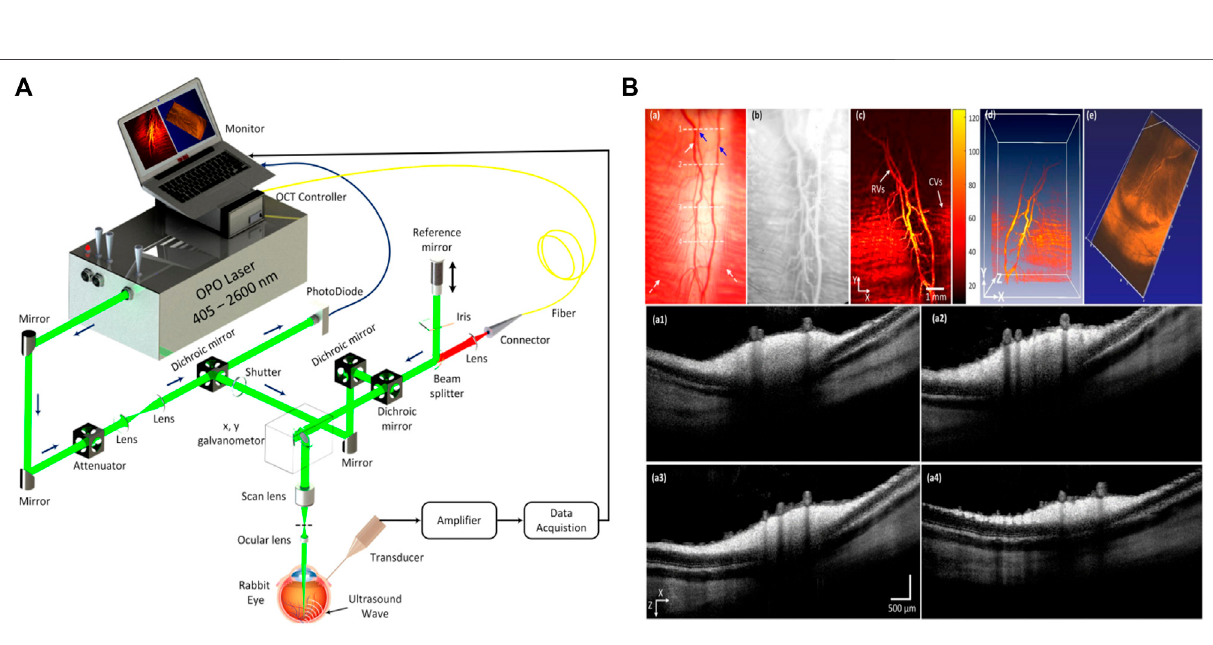
FIGURE 8 | (A) Schematic diagram of the integrated PAM and OCT systems for multimodal retinal imaging. Reprinted with permission from [147]; (B) images of retinal blood vessels in rabbits: (a) color fundus photography of retina. (b) Fluorescein angiography image showing retinal and choroidal capillaries. (c) Corresponding maximum amplitude projection PAM images of retina; (d,e) volumetric PAM and OCT image, respectively. (a1 – a4) Cross-sectional OCT images acquired along the scanning lines from (a) . Reprinted with permission from